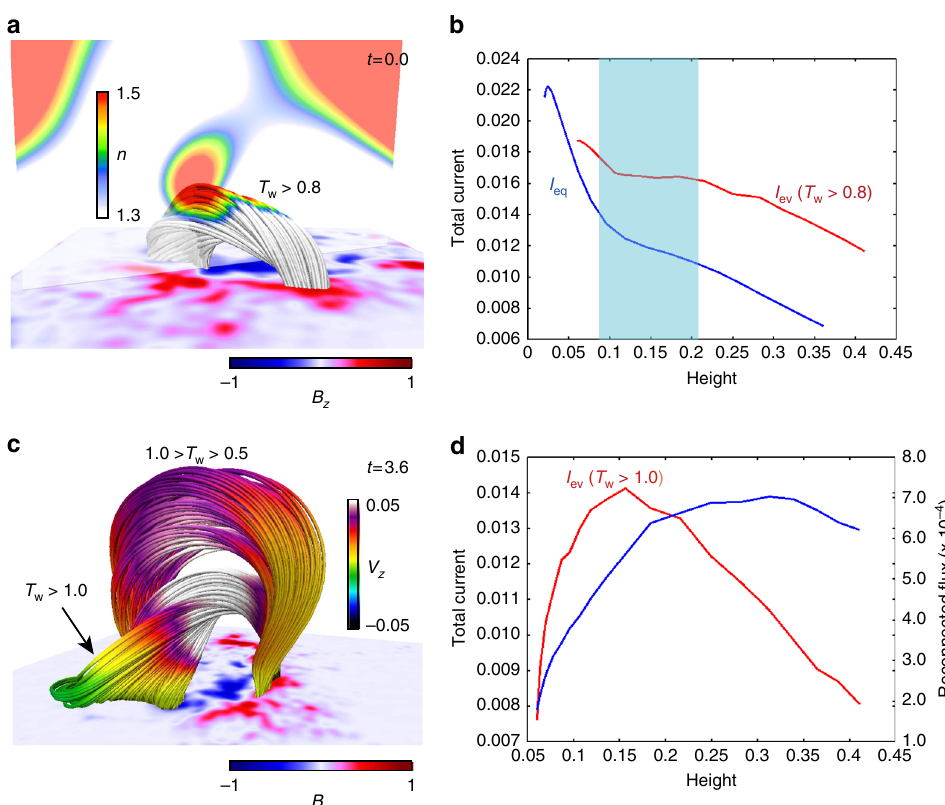
Fig. 8 Evolution of the total Current in the Evolving Flux Tube. a The 3D fi eld lines, all of which are twisted lines satisfying T w ≥ 0.8, at t = 0.0 (just after the tether-cutting reconnection) and the vertical cross section drawn with the decay index n in the range from 1.3 to 1.5. The bottom shows the B z distribution. b The red line corresponds to an evolution of the total current fl owing in the evolving twisted fl ux tube, which is de fi ned as a cluster of the twisted lines with T ≥ 0.8. The blue line shows the evolution of the current fl ux I fl ux tube at each hight. The blue mask eq determining the equilibrium state of the w corresponds to the region where n ≤ 1.5 satis fi es during which the velocity increases as seen in Fig. 6. c The 3D fi eld lines, those are highly ( T w ≥ 1.0) and moderately (1.0 > T w ≥ 0.5) twisted lines, at t = 0.36 represented with V z . d The evolution of the total current with height, fl owing in the evolving highly twisted fl ux tube ( T w ≥ 1.0) in red and the magnetic fl ux in blue,